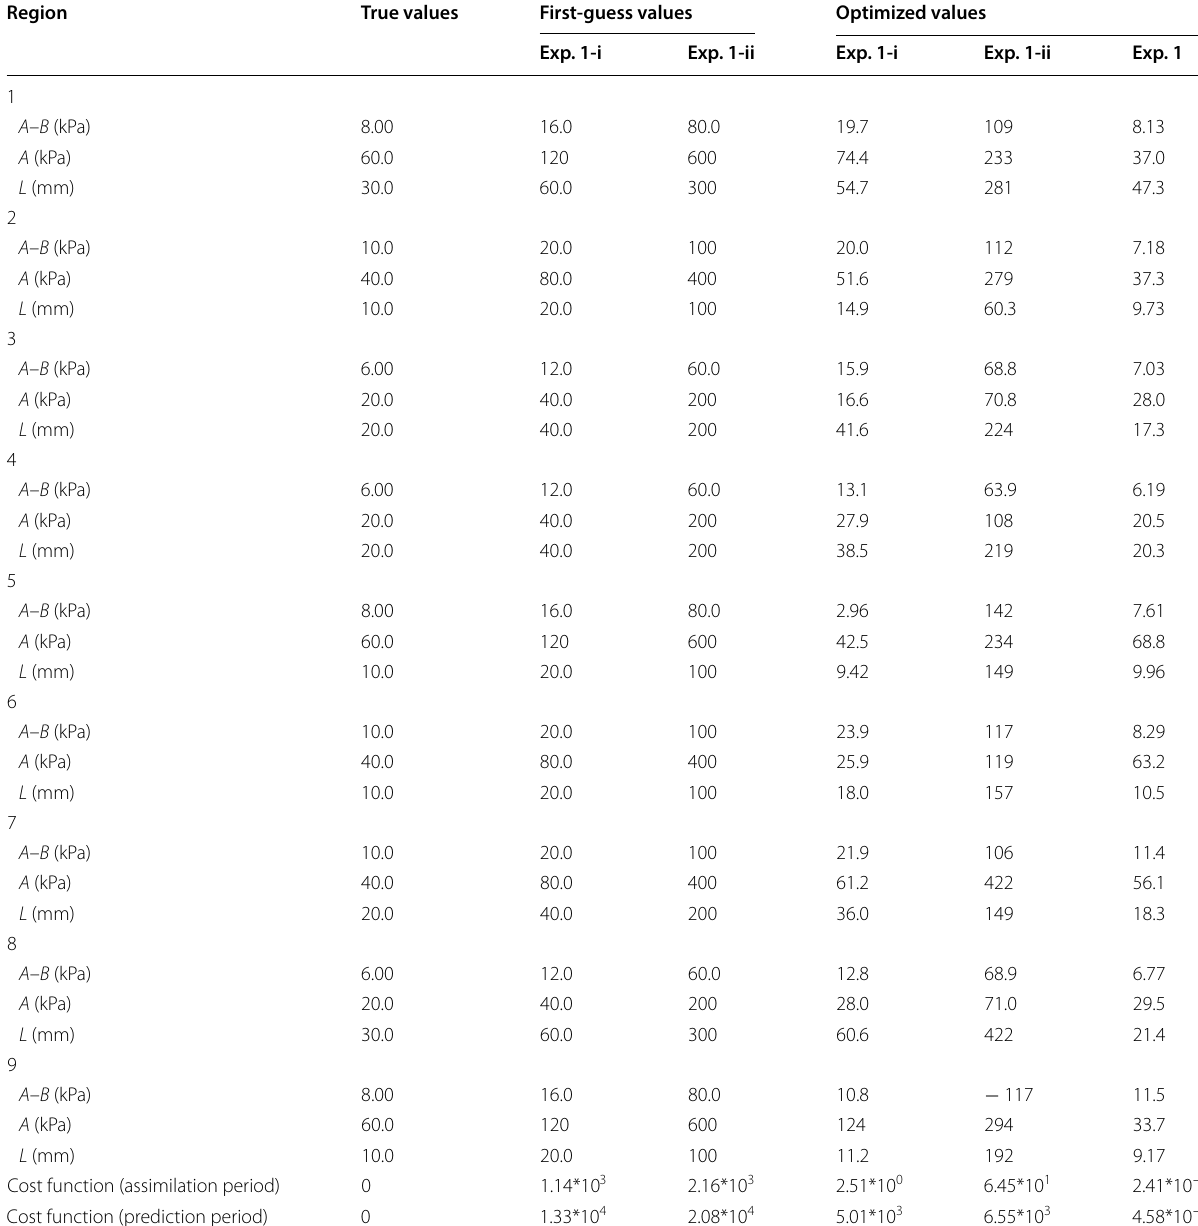
Table 3 True, first-guess and optimized values of frictional parameters in each subregion in the numerical experiments in Exps. 1-i, 1-ii, and 1, and values of the cost function calculated by using Eq. (7)